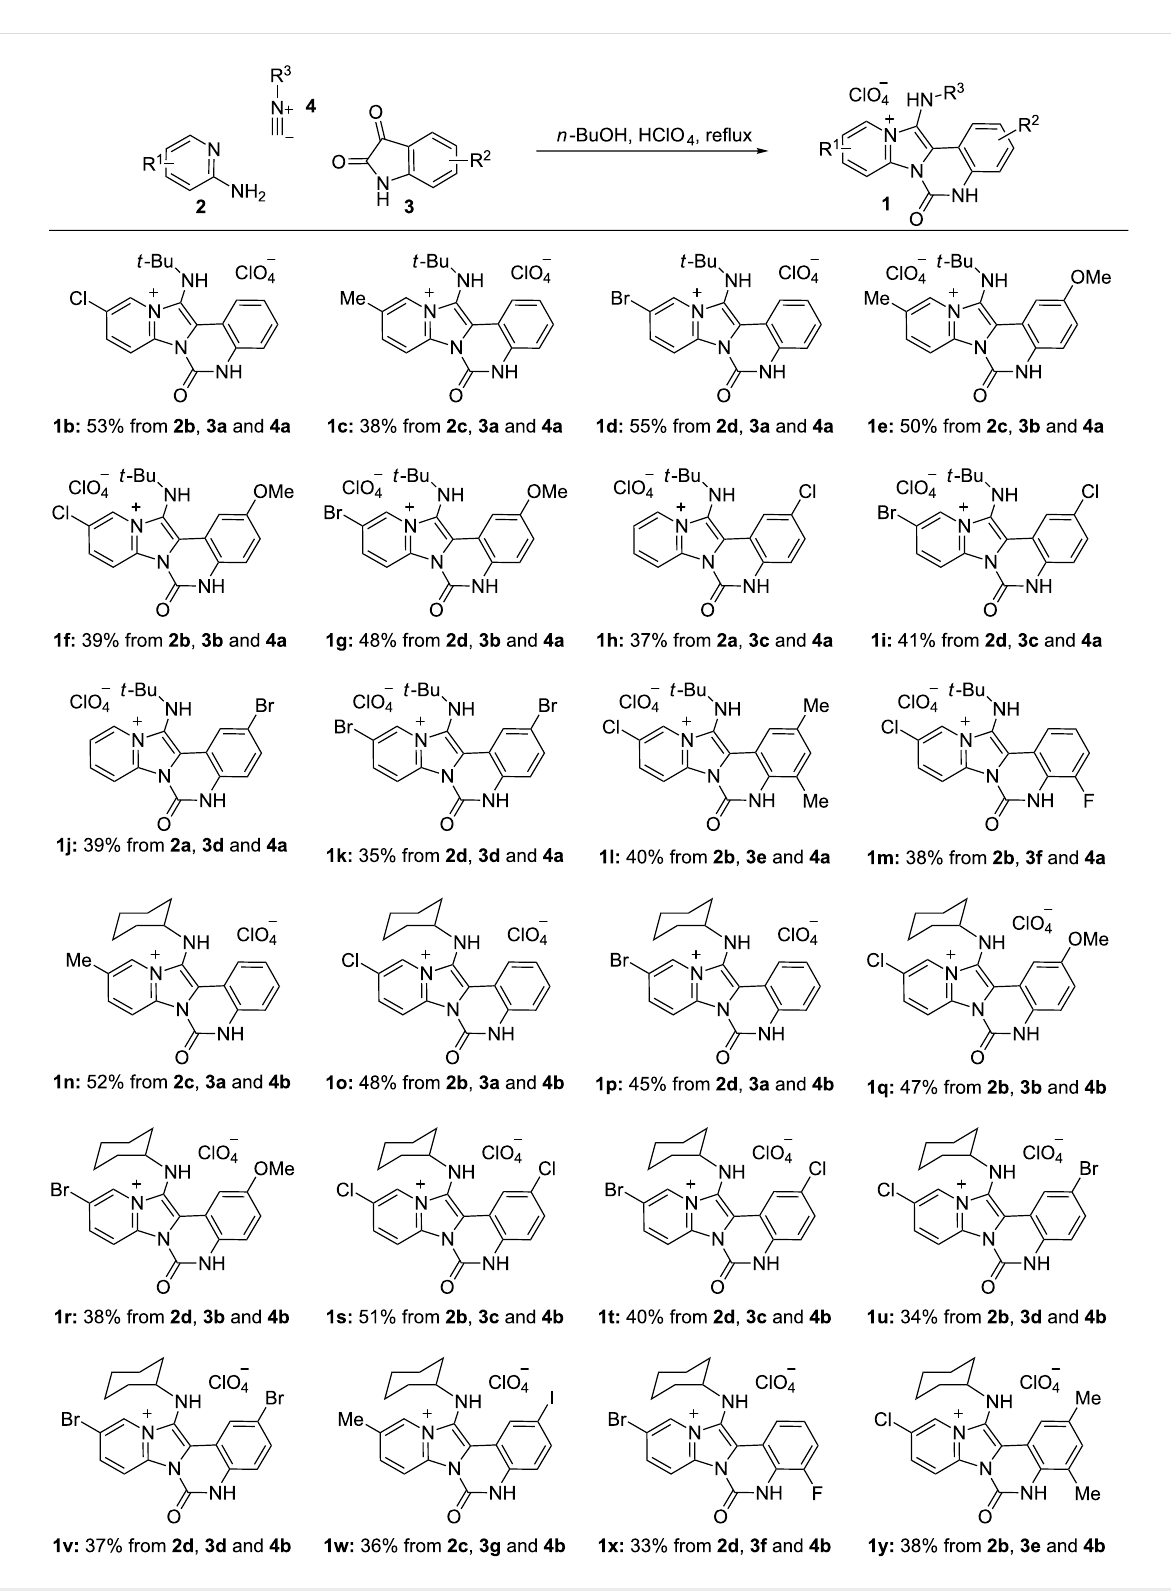
Figure 1: Syntheses of imidazo[1,2- a ]pyridine derivatives. Reaction conditions: 2 (1.35 mmol), 3 (1 mmol), 4 (1.35 mmol), HClO 4 (1 mmol), n -BuOH (4 mL), reflux. Yields refer to isolated yields. 2b R 1 = 4-Cl; 2c R 1 = 4-Me, 2d R 1 = 4-Br; 3b R 2 = 5-OMe; 3c R 2 = 5-Cl; 3d R 2 = 5-Br; 3e R 2 = 5,7-Me 2 ; 3f R 2 = 7-F; 3g R 2 = 5-I; 4b R 3 =